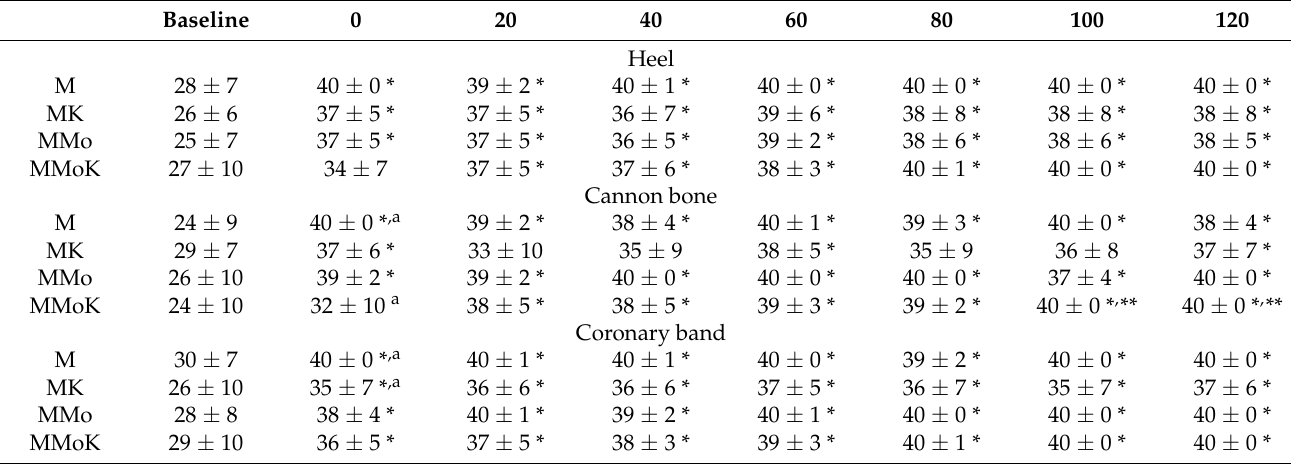
Table 3. Mechanical nociception: Maximum pressure (N) applied with the manual algometer at each anatomic site, before any drug administration (baseline) and each 20 min during the infusion in the four treatment groups, with a security endpoint of 40 N. * Significantly different ( p < 0.05) from baseline within a treatment. a,b,c,d Different superscript letters indicate significant differences ( p < 0.05) between treatments at this timepoint. ** Significantly different ( p < 0.05) from time 0 within a treatment.